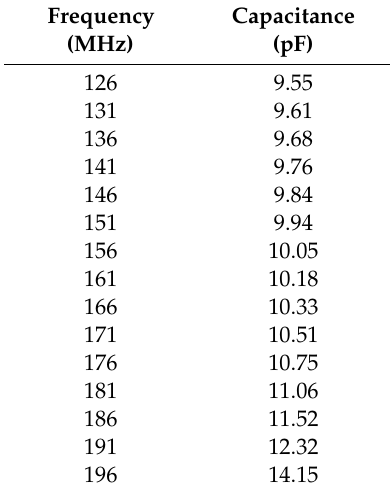
Table 4. Capacitance of the antenna versus frequency.